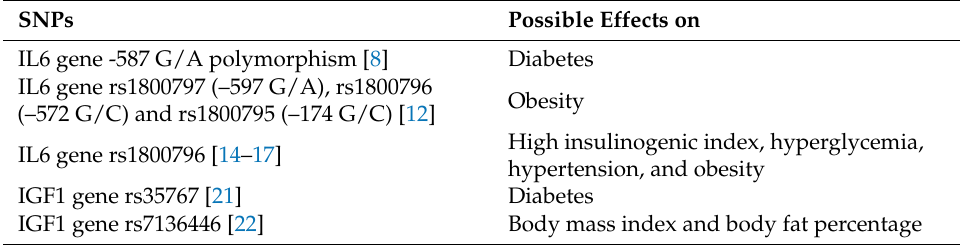
SNPs: single nucleotide